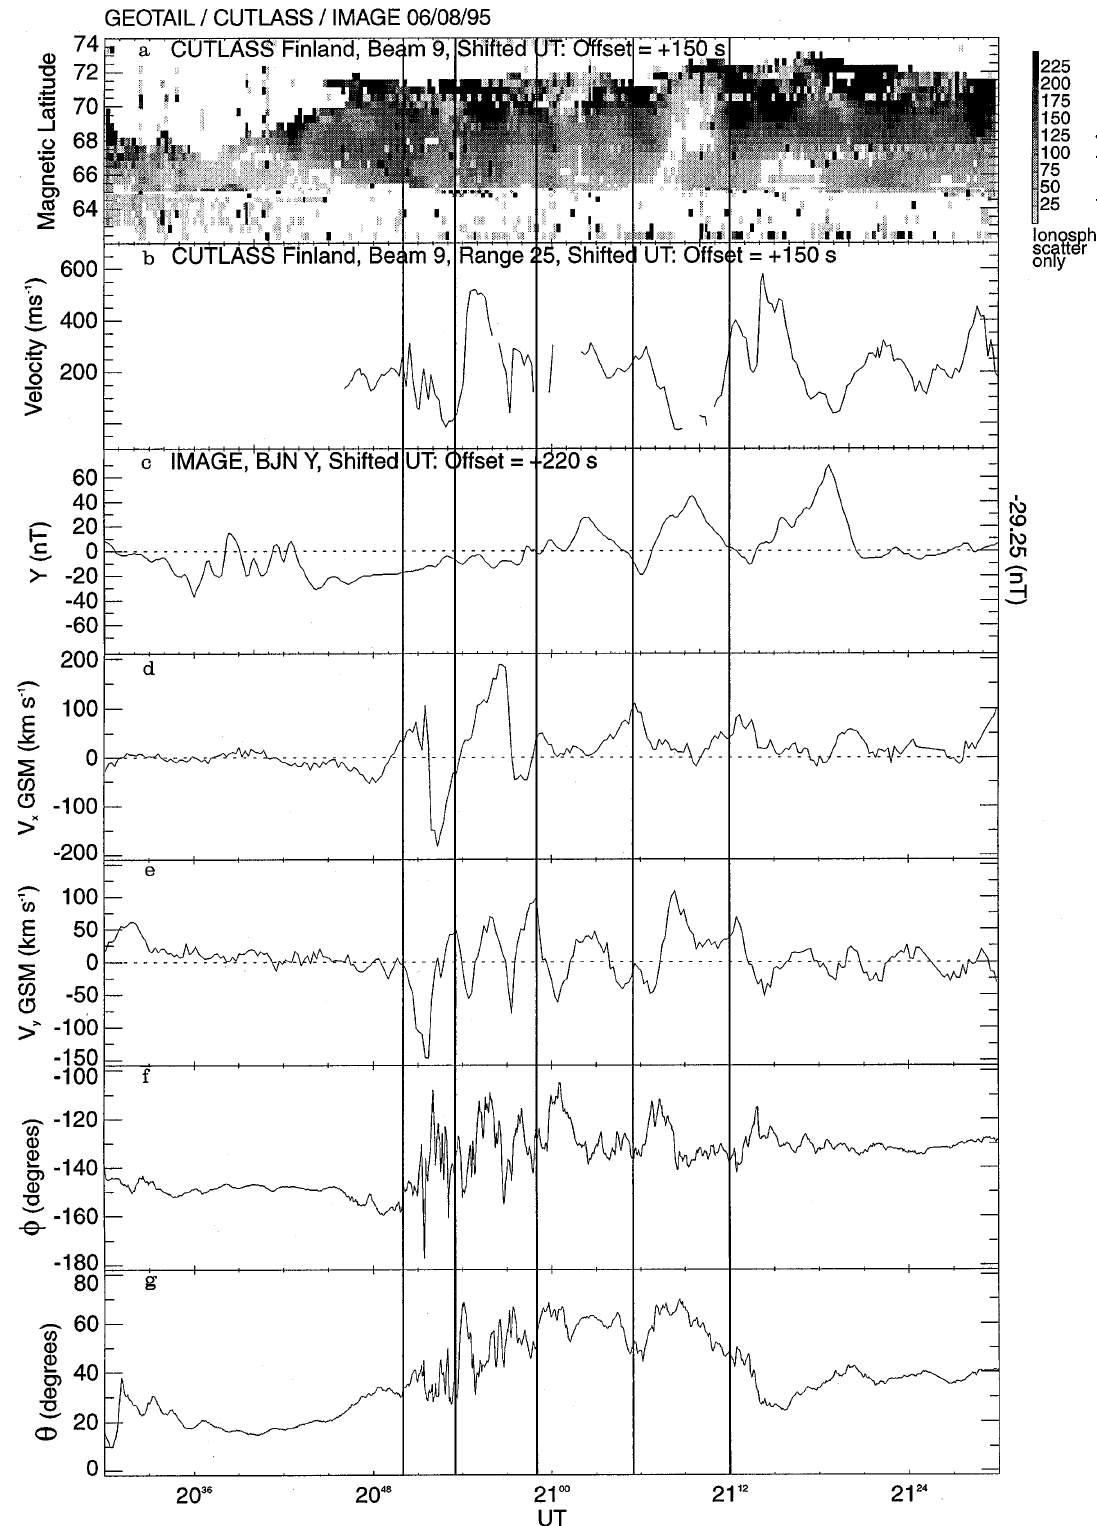
Fig. 5a–g. A comparison of the ground-based and Geotail data. a and b show the CUTLASS Finland ionospheric convection velocity (positive Doppler velocity represents flow toward the radar, or equatorward flow) in beam 9 of the radar and from the beam-range cell which overlies Bjørnøya (BJN). c presents the Y component of the